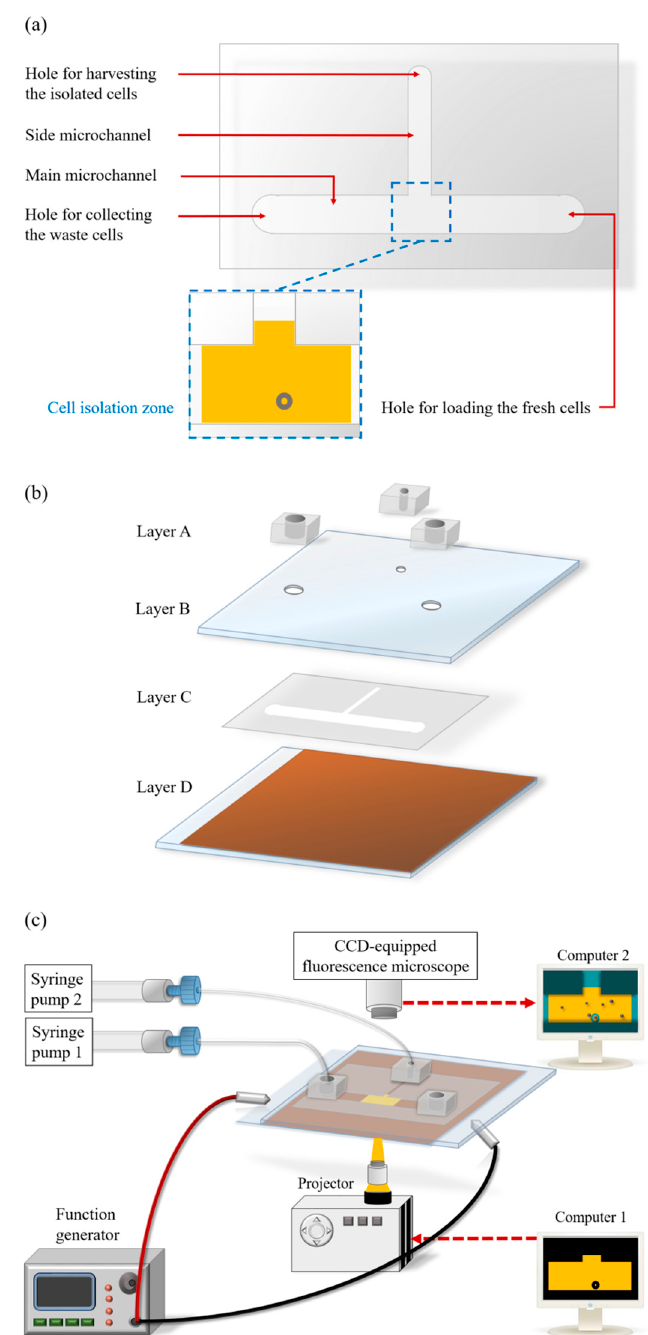
Figure 1. Schematic illustration of the ( a ) top-view layout and ( b ) assembly of the optically induced dielectrophoresis (ODEP) microfluidic system (Layer A: fabricated polydimethylsiloxane (PDMS) components; Layer B: indium-tin-oxide (ITO) glass; Layer C: double-sided adhesive tape with microfabricated microchannels; Layer D: ITO glass substrate coated with a layer of photoconductive material), and the ( c ) overall experimental setup.